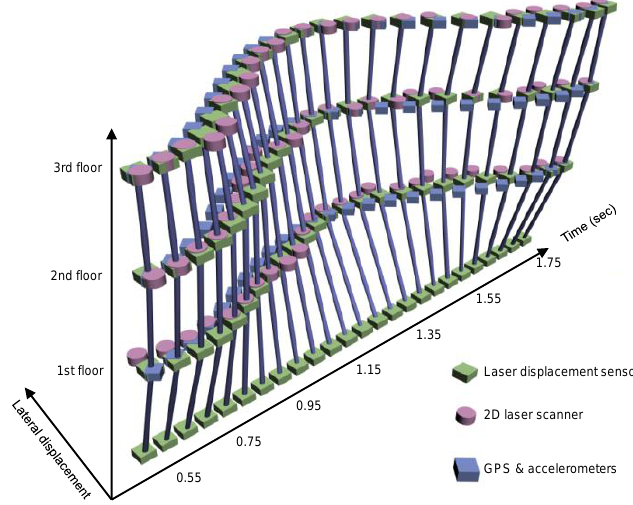
Figure 8. Comparison of deformed shapes of the test model.